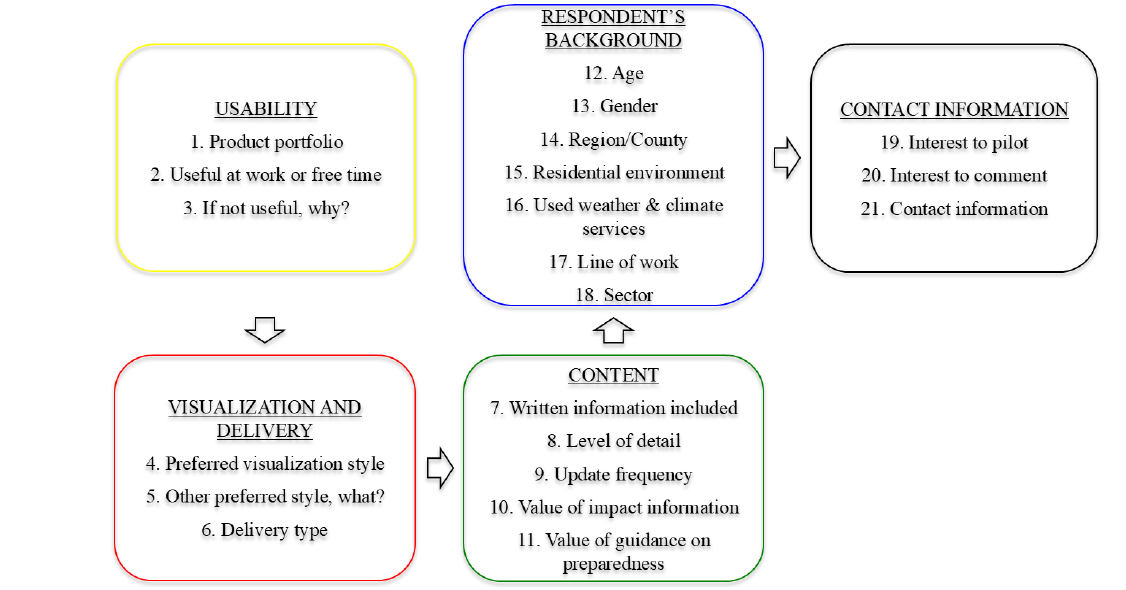
Figure 1. The survey structure consisted of five thematic sections: usability (yellow), visualization and delivery (red), content (green), respondent’s background (blue), contact information (black). Depending on the previous answers, not all questions had to be